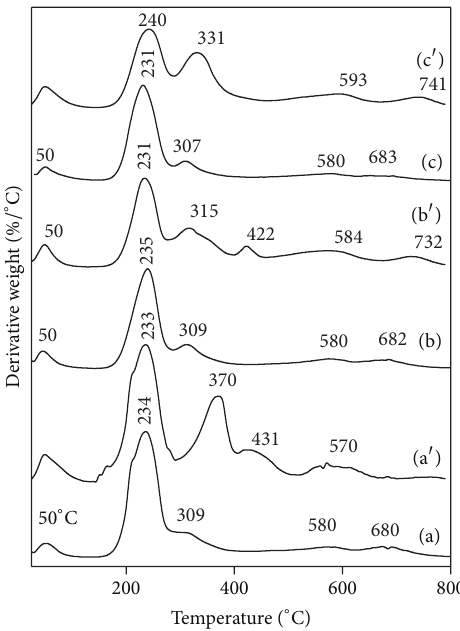
Figure 3: Derivative thermogravimetric analysis (DTG) curves of (a) C16TMA-Mt, (b) C16TMA-AMt0.2, (c) C16TMA-AMt0.5, (a 󸀠 ) PVP/C16TMA-Mt, (b 󸀠 ) PVP/C16TMA-AMt0.2, and (c 󸀠 ) PVP/ C16TMA-AMt0.5. Figure 4: In situ XRD patterns of C16TMA-AMt0.5 calcined at different temperatures. (a) 25, (b) 100, (c) 150, (d) 200, (e) 215, (f) 250, and (g) 300 ∘ C. ∗ corresponds to C16TMABr salt as